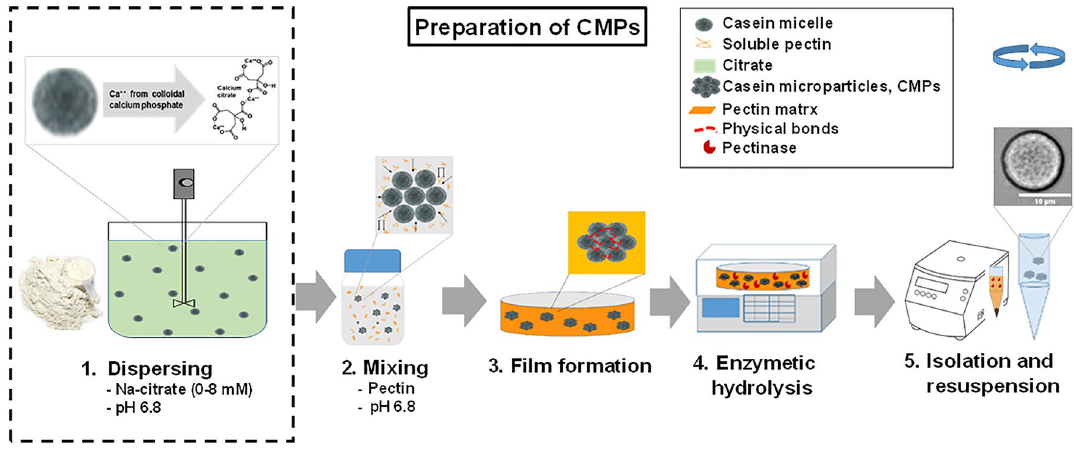
Figure 1. Process steps of producing casein microparticles at pH